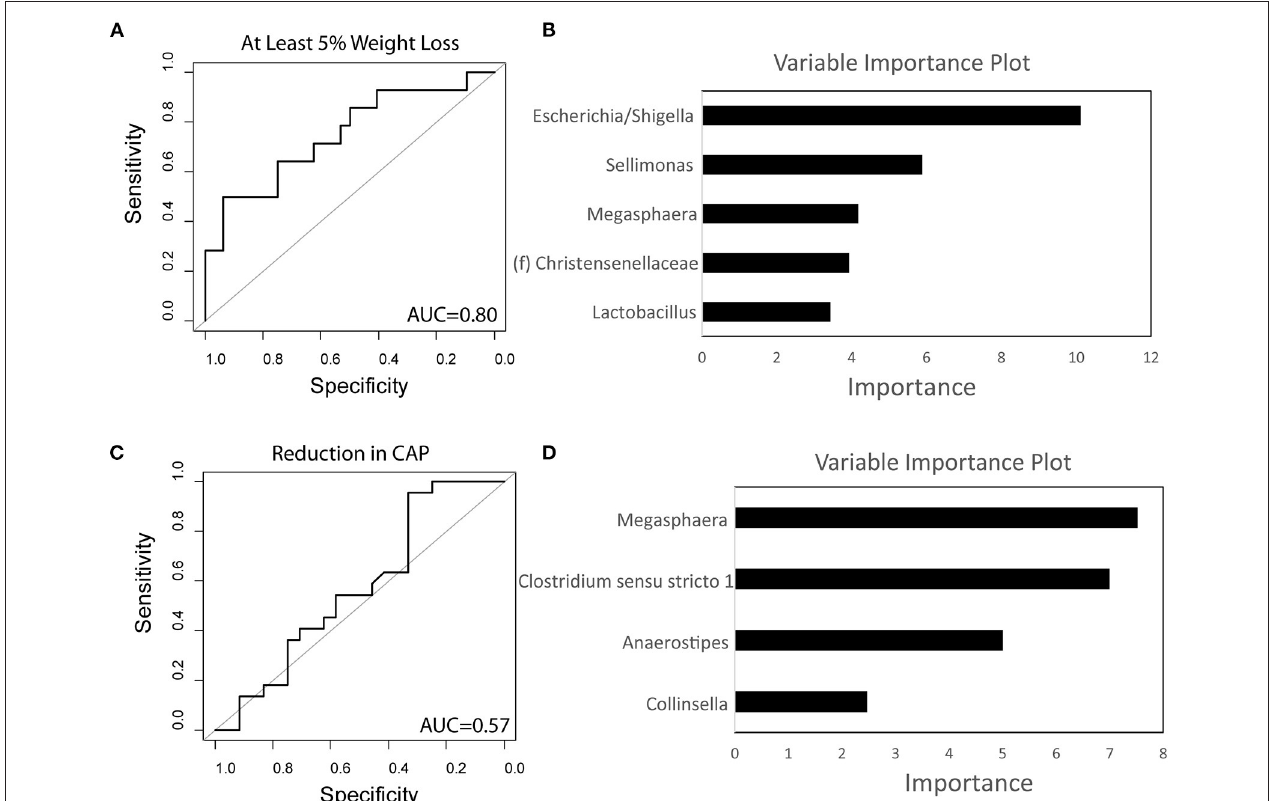
FIGURE 5 | Baseline microbiome predicts weight loss on a calorie-restricted diet. (A) Receiver operating characteristic curve of the random forest classifier using baseline microbiome data to predict at least 5% weight loss. (B) Variable importance plot of the classifier for weight loss. (C) Receiver operating characteristic curve of the random forest classifier using baseline microbiome data to predict reduction in hepatic steatosis as measured by controlled attenuated parameter (CAP). (D) Variable importance plot of the classifier for steatosis. AUC, Area under the